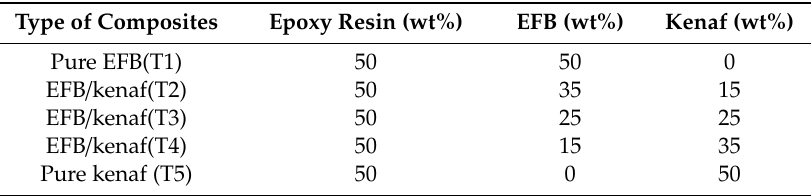
Table 2. Formulations of oil palm empty fruit bunch (EFB) / kenaf woven fiber-reinforced epoxy-based bi-layer hybrid